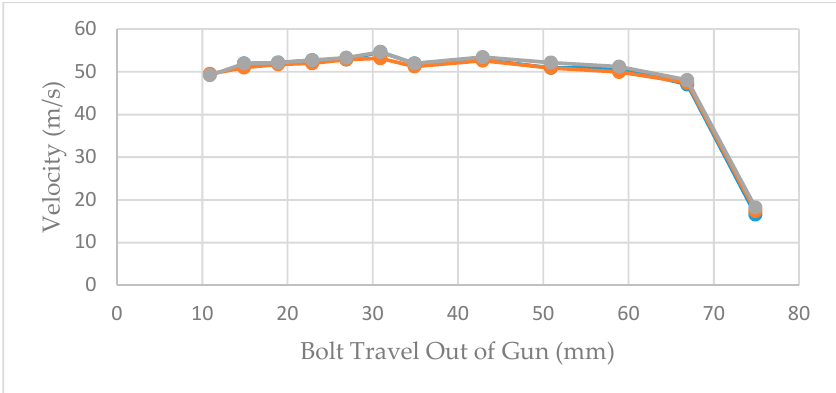
Figure 10. Bolt velocities recorded by the velocimeter at the different measurement points; 10 shots using 4.00 grain cartridges.